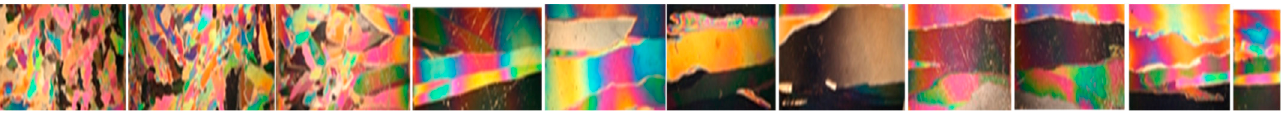
Figure 3. Crystals of reservoir ice from the surface to the bottom in Hongqibao Reservoir (a total length of 85 cm) (modified from Ref. [42]).